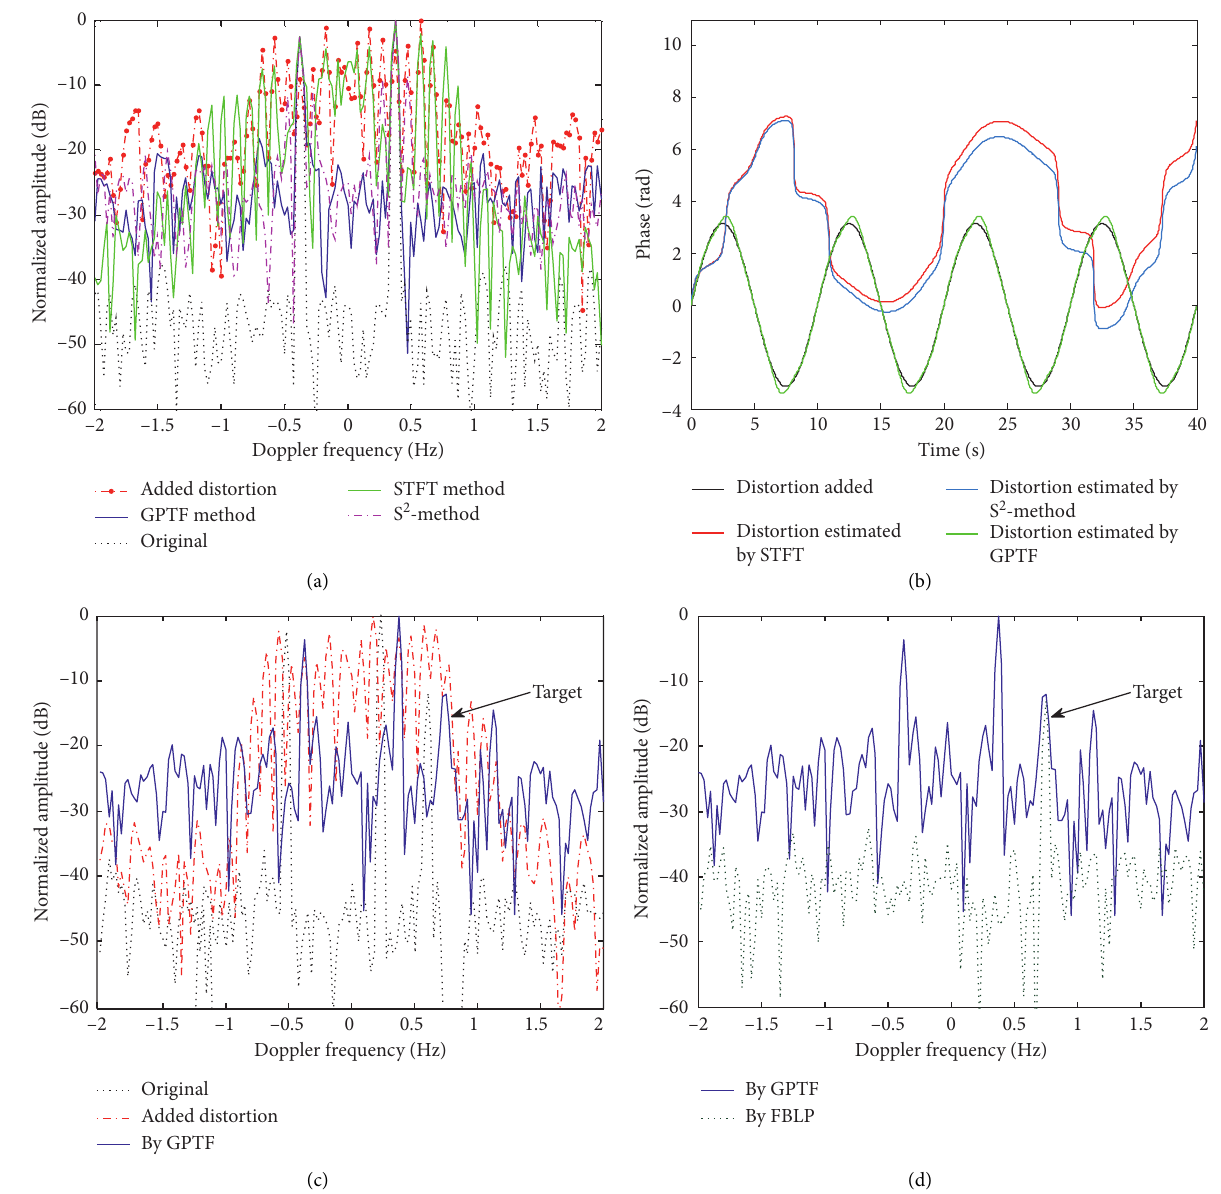
Figure 6: Sea clutter suppression with ionospheric phase disturbance based on GPTF and FBLP. (a) Contaminated sea clutter and decontaminated sea clutter spectrum by S 2 -method, STFT, and GPTF. (b) Estimated phase contamination by PGA, STFT, and GPTF. (c) Decontaminated sea clutter spectrum by GPTF. (d) The broadening sea clutter suppression based on the FBLP